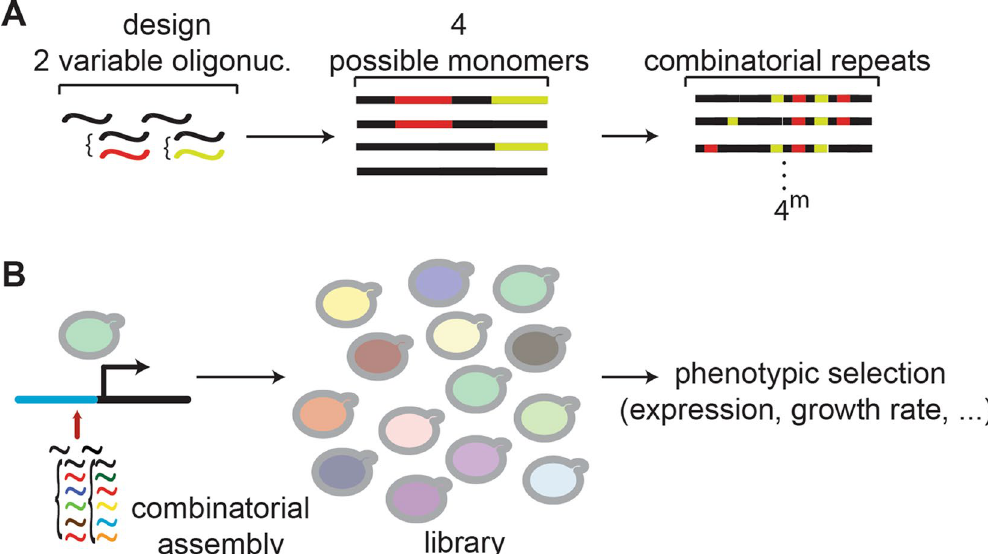
Figure 4. Engineering of a combinatorial library of tandem DNA repeat arrays. (A) Example is given for a four oligonucleotide design with two variable oligonucleotides. m being the number of repeat in a given array, there are 4 m possible arrays of length m. (B) Example strategy to design a combinatorial library of promoter sequences, using a collection of oligonucleotides with diverse transcription factor binding sites. Upon transformation, the library can be selected based on gene expression, fitness, or other selectable